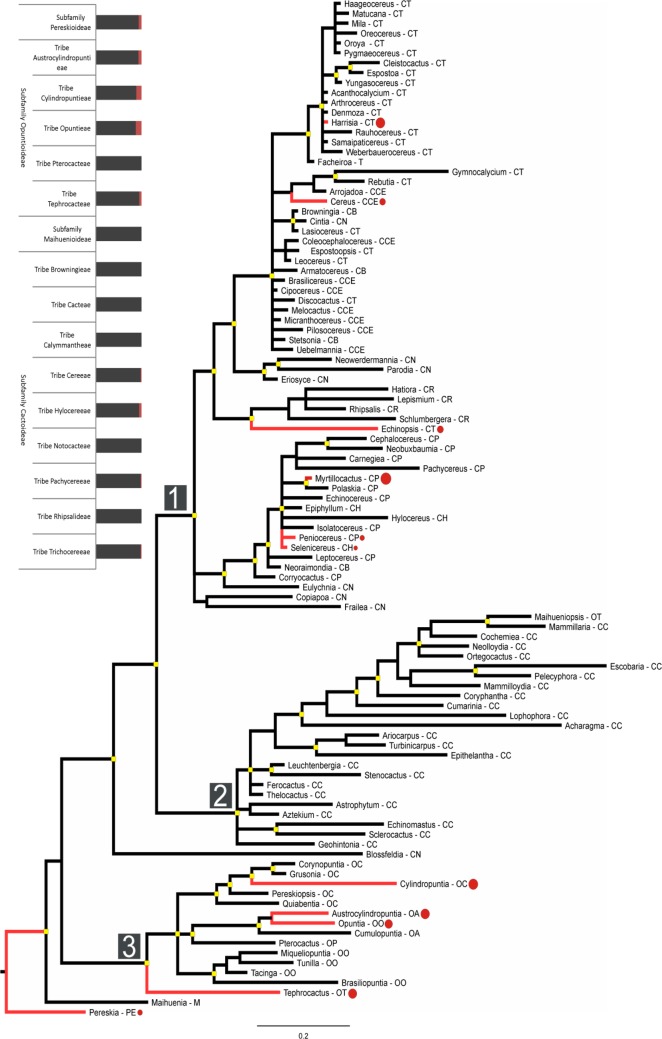
Bayesian phylogeny based on matK DNA sequence data illustrating phylogenetic relationships among genera within Cactaceae. The aligned matK matrix contained 1354 characters and required 65 gaps (indels), ranging from 1 to 74 characters in size. Overall, the phylogeny yielded well-resolved relationships among all genera included. High nodal support (posterior probabilities >0.9) is indicated at nodes by yellow boxes. Genera with invasive taxa are indicated as red branches where red circles are proportional to the percentage of invasive taxa within each genus. Scale bar = number of substitutions/site. The three main clades are indicated under the numbers 1, 2 and 3. CB: Subfamily Cactoideae, Tribe Browningieae; CC: Subfamily Cactoideae, Tribe Cacteae; CCE: Subfamily Cactoideae, Tribe Cereeae; CH: Subfamily Cactoideae, Tribe Hylocereeae; CN: Subfamily Cactoideae, Tribe Notocacteae; CP: Subfamily Cactoideae, Tribe Pachycereeae; CR: Subfamily Cactoideae, Tribe Rhipsalideae; CT: Subfamily Cactoideae, Tribe Trichocereeae; OA: Subfamily Opuntioideae, Tribe Austrocylindropuntieae; OC: Subfamily Opuntioideae, Tribe Cylindropuntieae; OO: Subfamily Opuntioideae, Tribe Opuntieae; OP: Subfamily Opuntioideae, Tribe Pterocacteae; OT: Subfamily Opuntioideae, Tribe Tephrocacteae; M: Subfamily Maihuenioideae. PE: Subfamily Pereskioideae. The bars in the left graph indicate the percentage of non-invasive species (black) against percentage of invasive species (red) per tribe or subfamily.